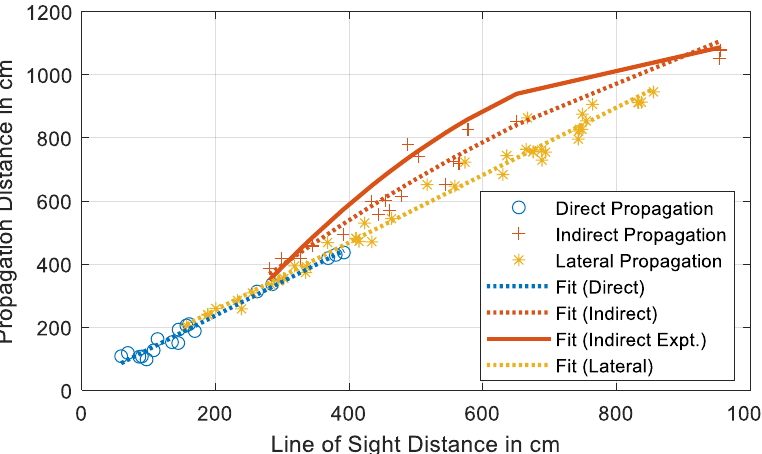
Figure 13. Relationship between propagation distance and LoS distance in the simulation model.